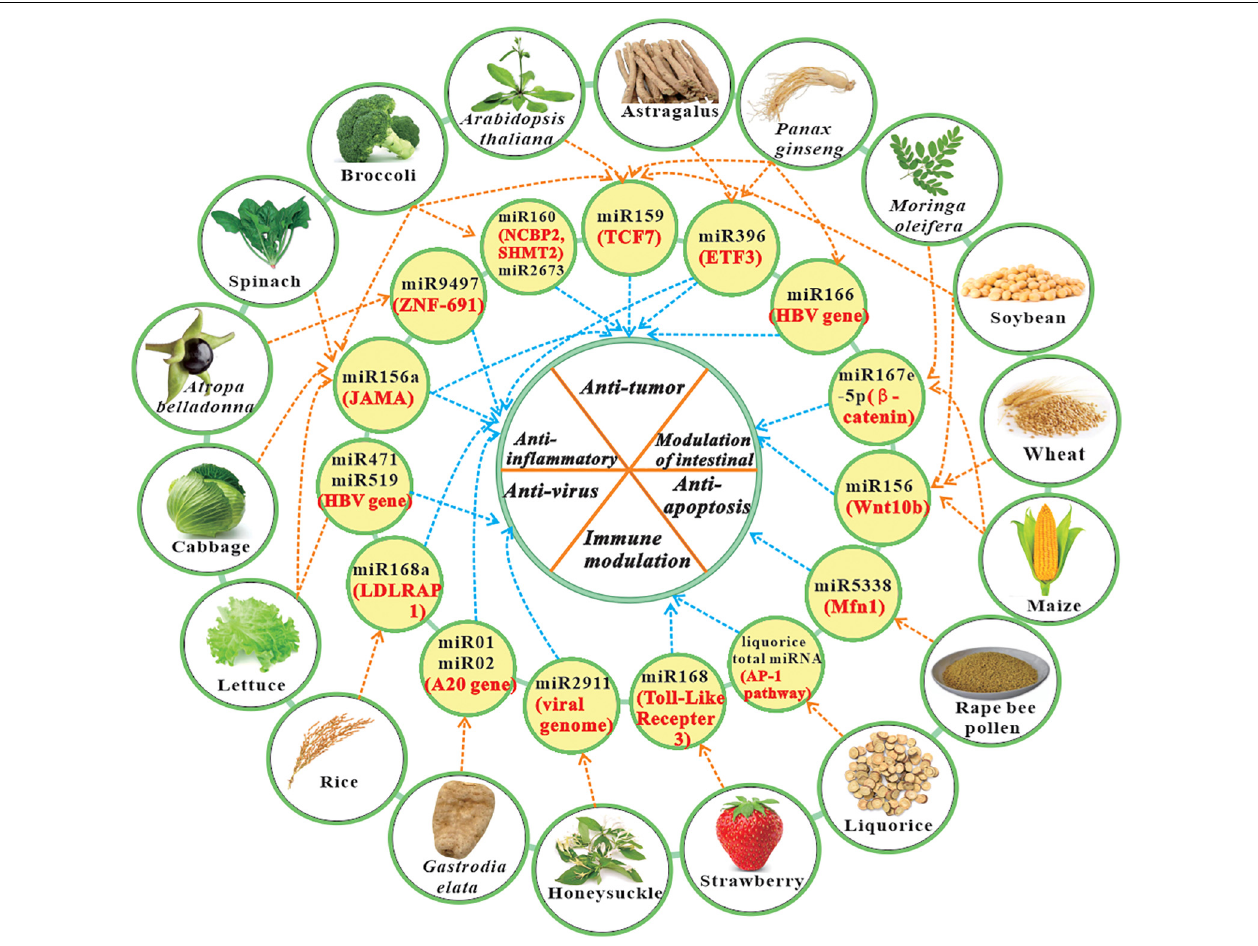
FIGURE 1 | The representative plant-derived miRNAs with cross-kingdom bioactivity and their role in cross-kingdom communications. Note: The information in yellow circle contains miRNAs derived from specific plants (black text) and their main targets (red text). Some conservative miRNA family can be found in many different plant species. Other information like miRNA sequence and references can be found in Table 1 . ETF3, Endothelial transcription factor 3; HBV, Hepatitis B virus; JAMA, Junctional adhesion molecule A; LDLRAP 1, Low-density lipoprotein receptor adapter protein 1; Mfn1, Mitochondrial fusion requires fusion protein